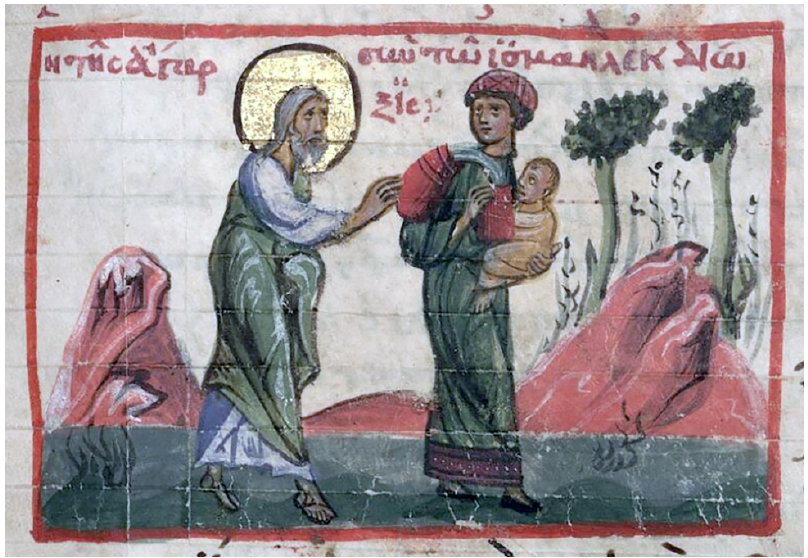
Figure 1. Octateuch , s. XII. Rome, Biblioteca Apostolica Vaticana, gr. 746, f. 80r.